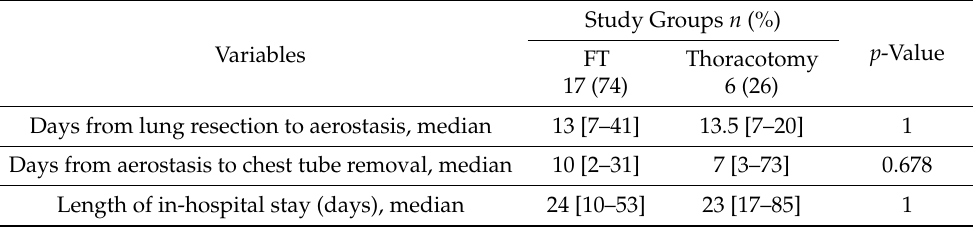
Table 3. Postoperative characteristics and outcomes ( n = sample size, % = percentages, [] = ranges).